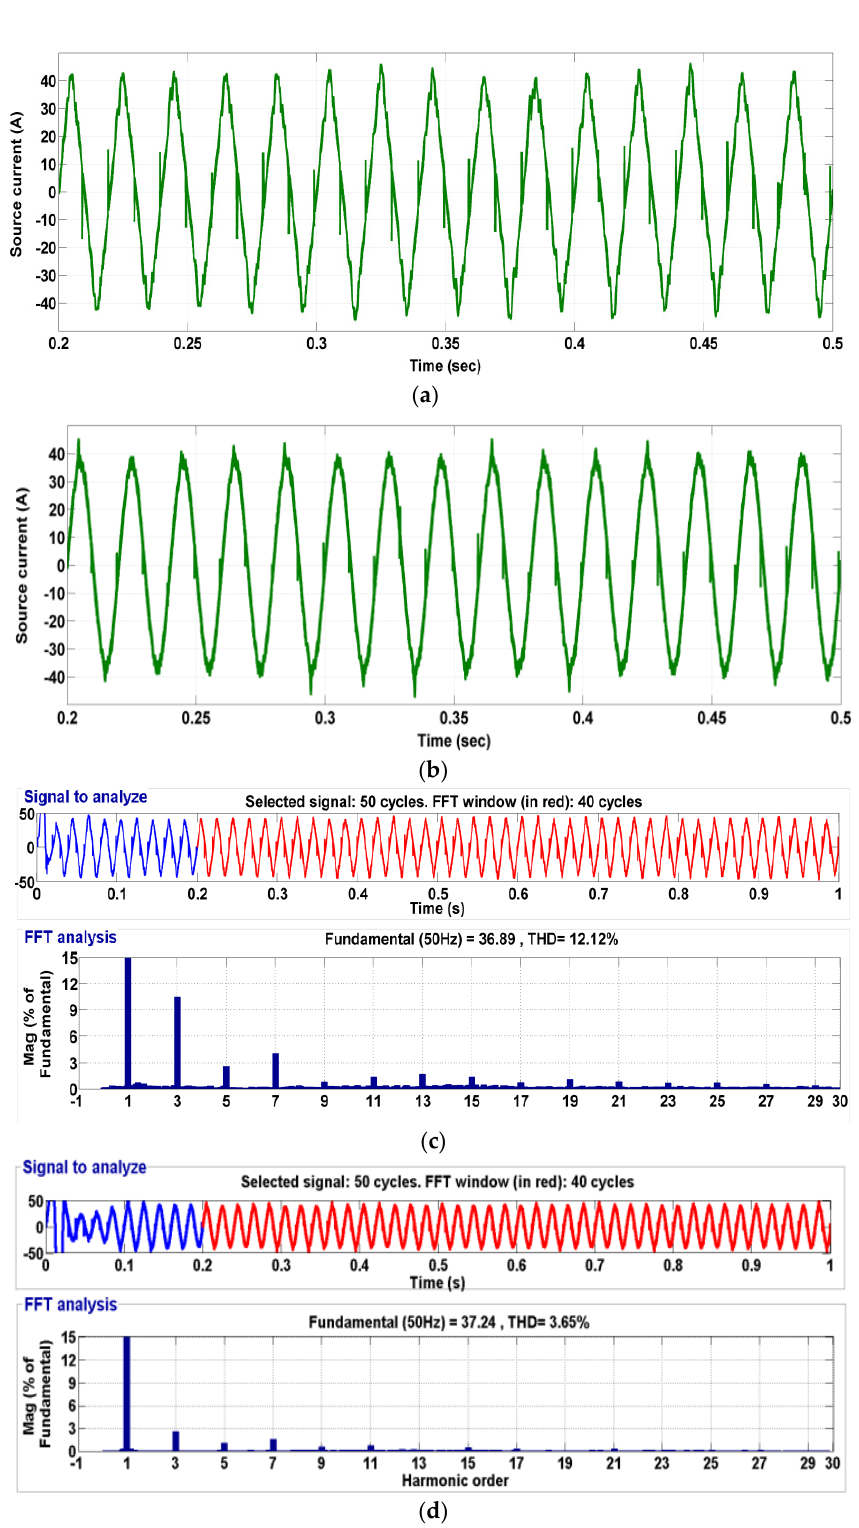
Figure 11. Source current analysis with UPC system under non ‐ sinusoidal voltage conditions: ( a ) source current waveform with PQ method; ( b ) source current waveform with SRF method; ( c ) FFT analysis of source current with PQ method; ( d ) FFT analysis of source current with SRF method.